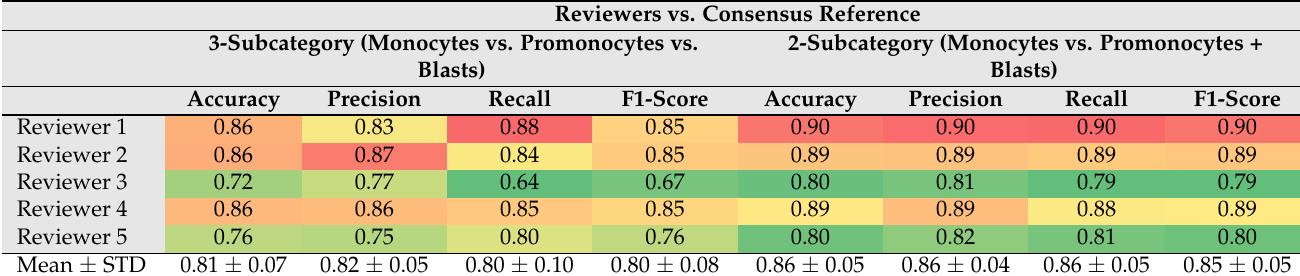
Table 4. Performance of human experts compared to consensus reference labels.